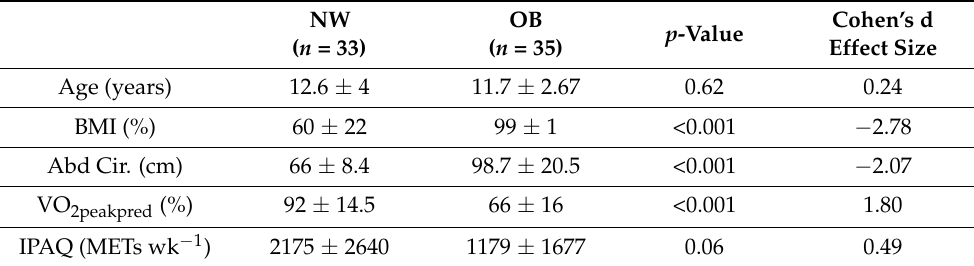
Table 1. Demographic, anthropometric, exercise, and physical activity